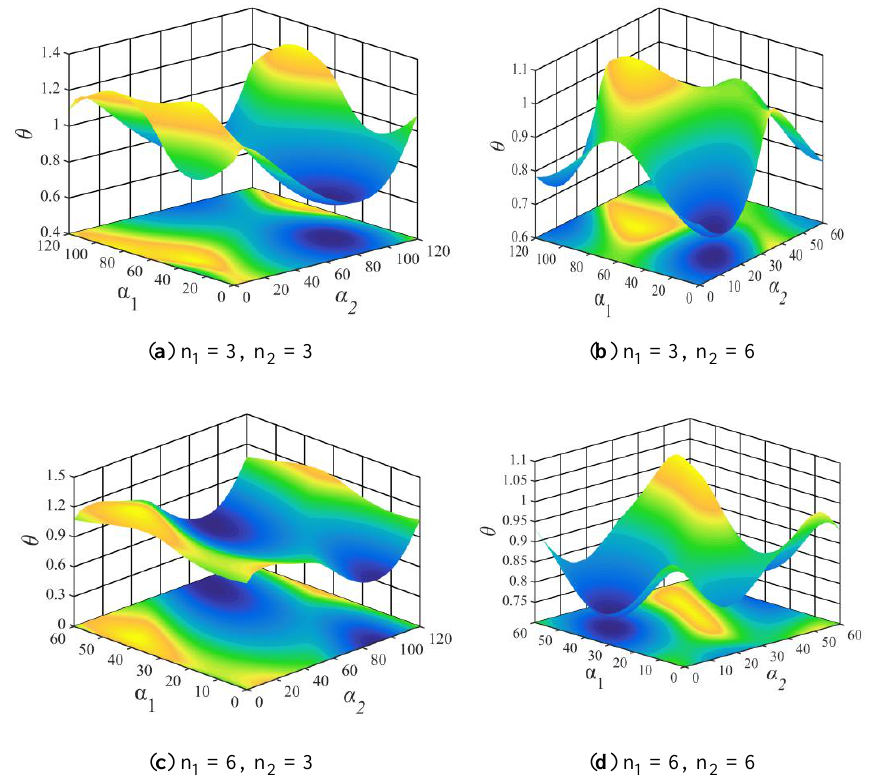
Figure 10. Variations of θ with the wave phase angle under four cases.